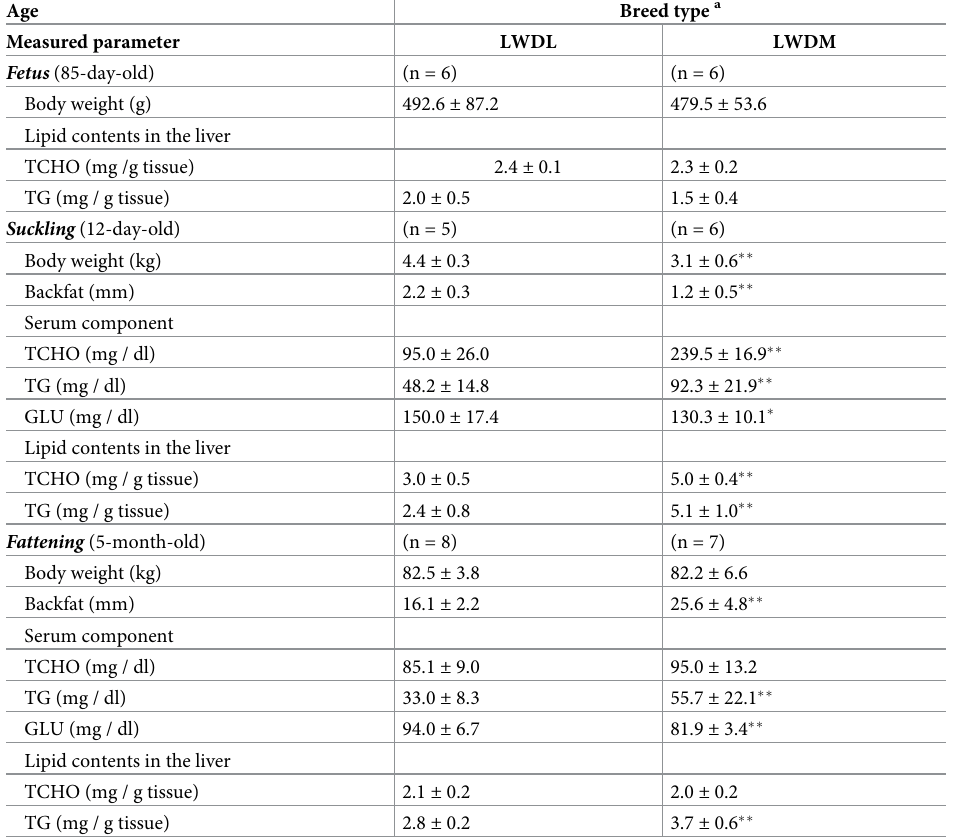
a In the columns of breed type, numbers of pigs used in the group are indicated in brackets. Abbreviations: TCHO, total cholesterol; TG, triglyceride; GLU, glucose. Asterisks indicate significant differences between LWDL